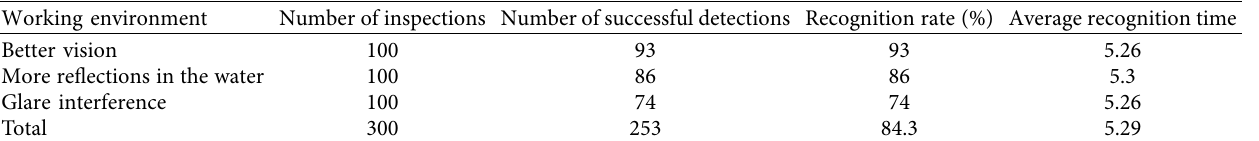
Figure 10: Experimental comparison chart. Table 4: Recognition